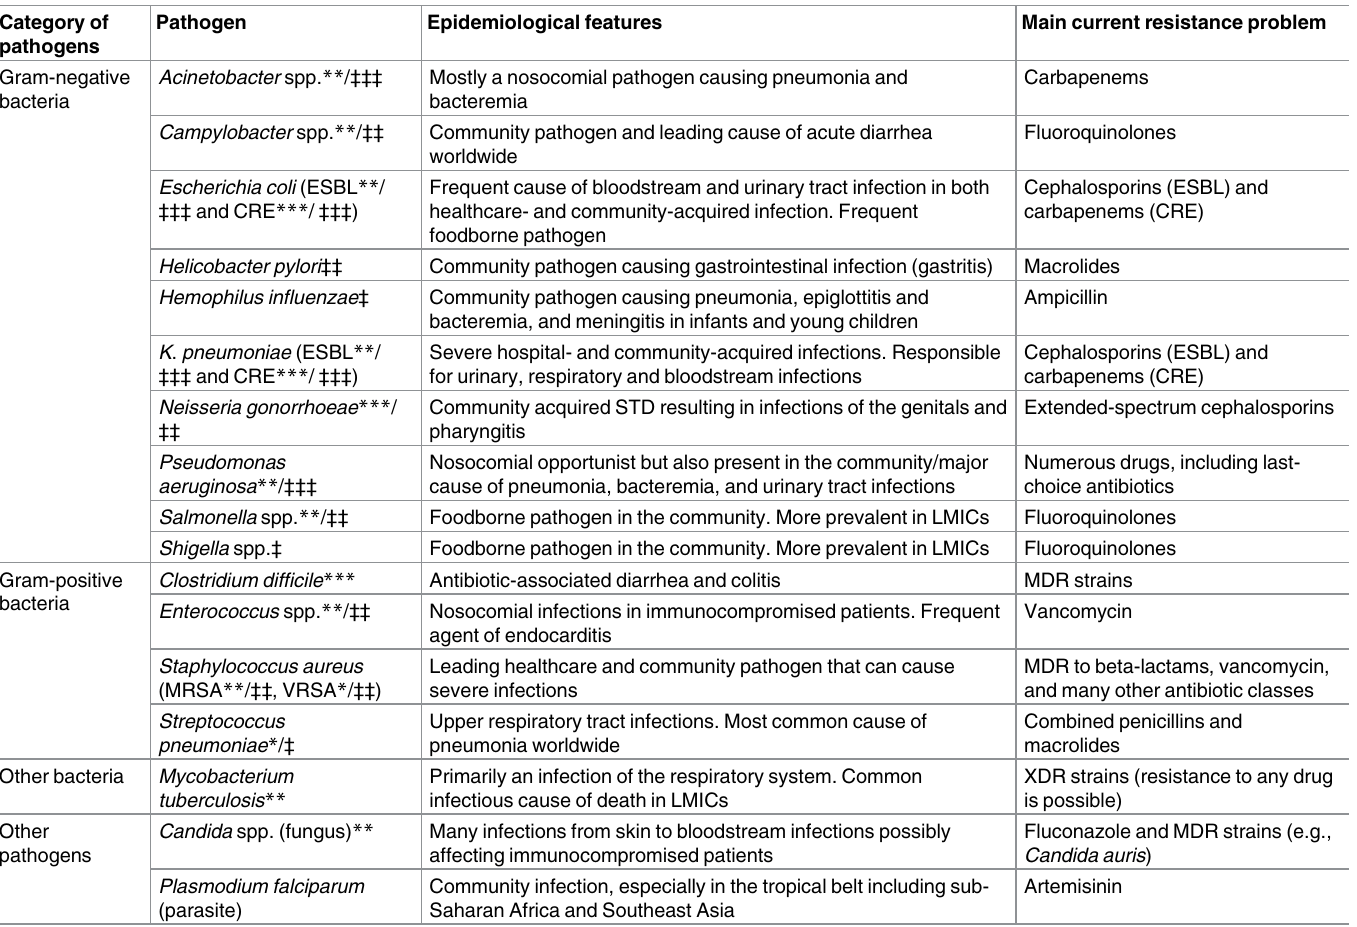
Table 2. State of AMR: Examples of relevant resistant pathogens in human